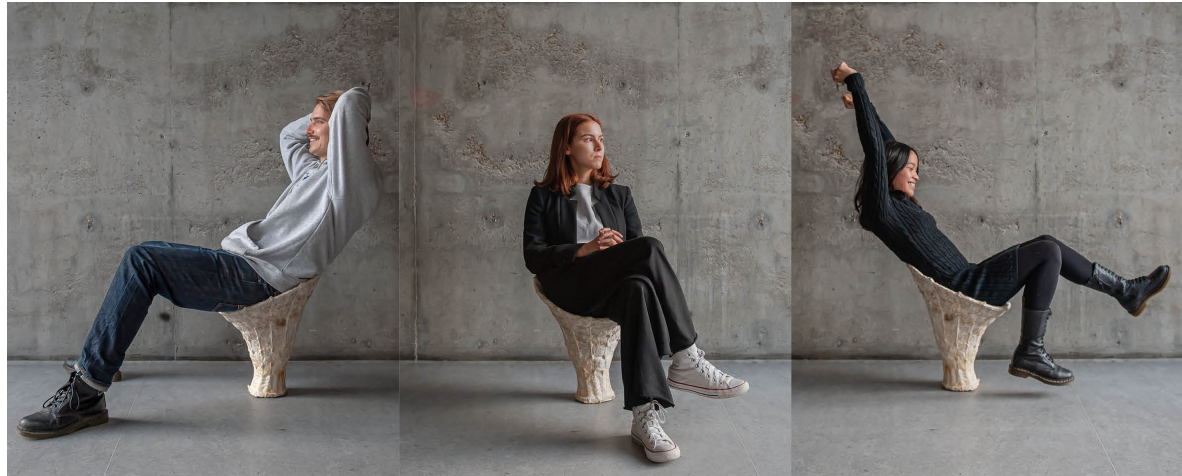
Figure 15. Seating tests (44 to 90 kilos).